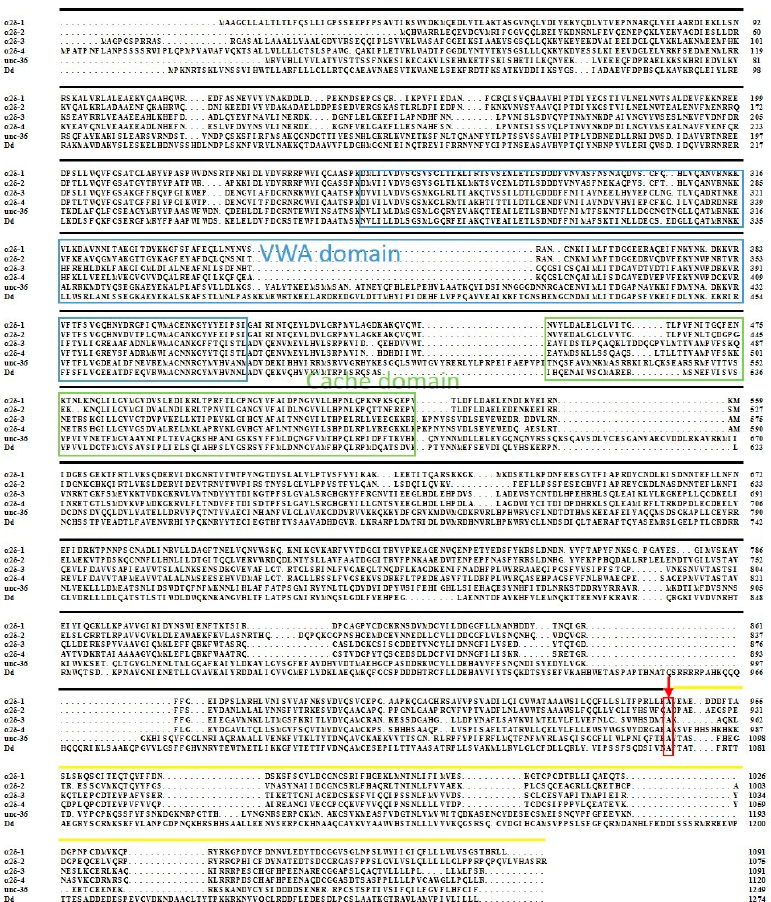
Figure 2. Amino acid sequence of the DdCa v α 2 δ subunit. Blue indicates cysteine residues, red indi- cates N-glycosylation sites, and underlining indicates suspected GPI anchor sites.